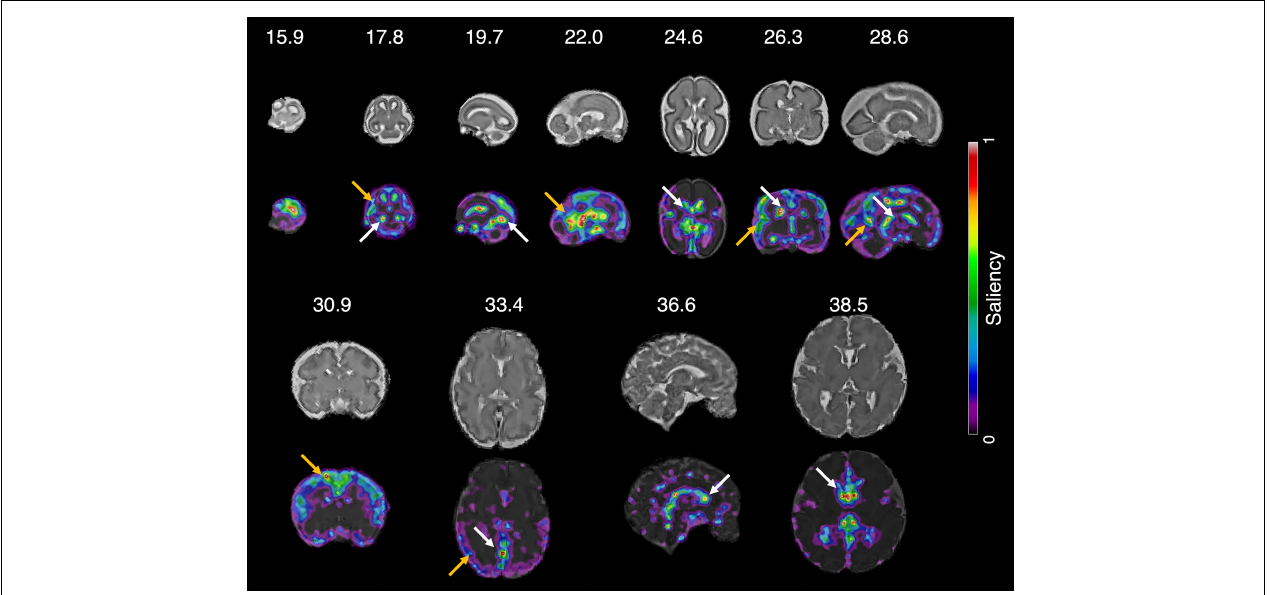
FIGURE 6 | Saliency map of fetal brain age prediction. Large saliency represents important regions contributing to fetal brain age prediction. For all slices, the cortex (yellow arrows) and ventricles (white arrows) had larger saliency values than the other brain regions.